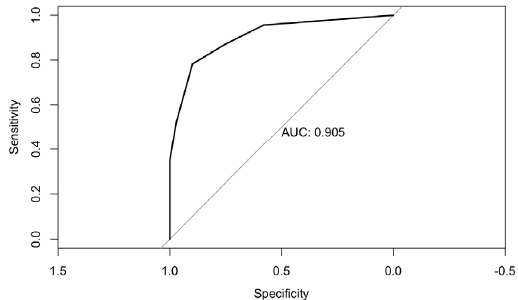
Figure 2. ROC curve of multiple logistic regression model using sE-selectin > 33 ng/mL, PaO 2 /FiO 2 200-300 and PaO 2 /FiO 2 < 200 as predictors of Intensive Care Unit (ICU) admission.